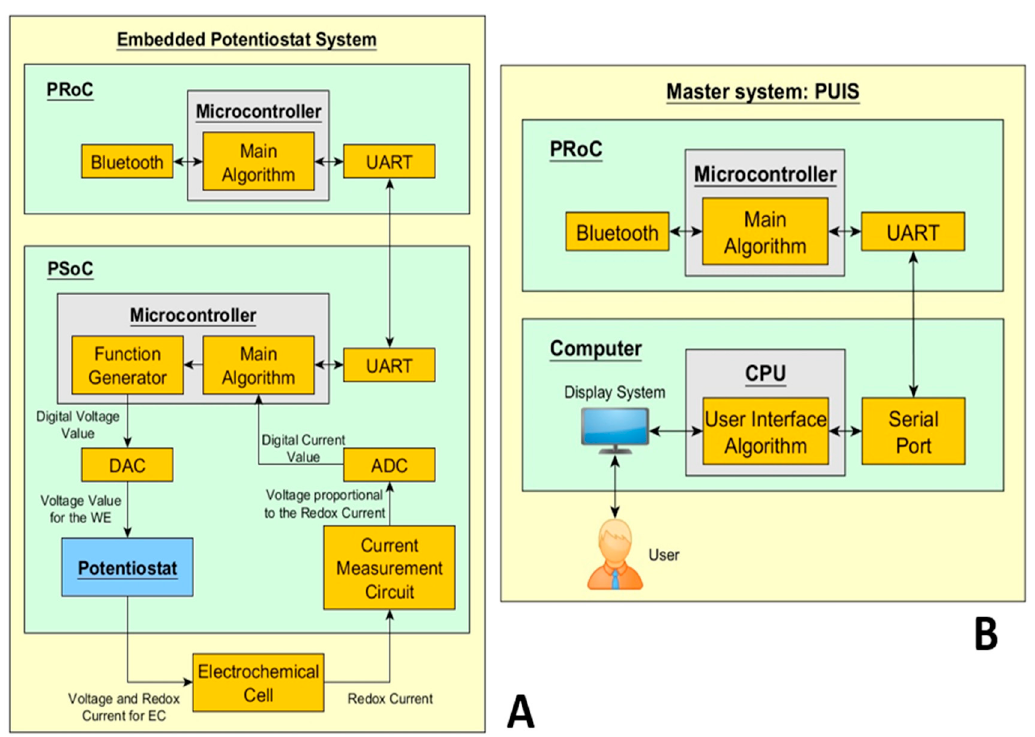
Figure 3. Modular Potentiostat: ( A ) Slave system of the EPS. ( B ) Master system with the structure PUIS.